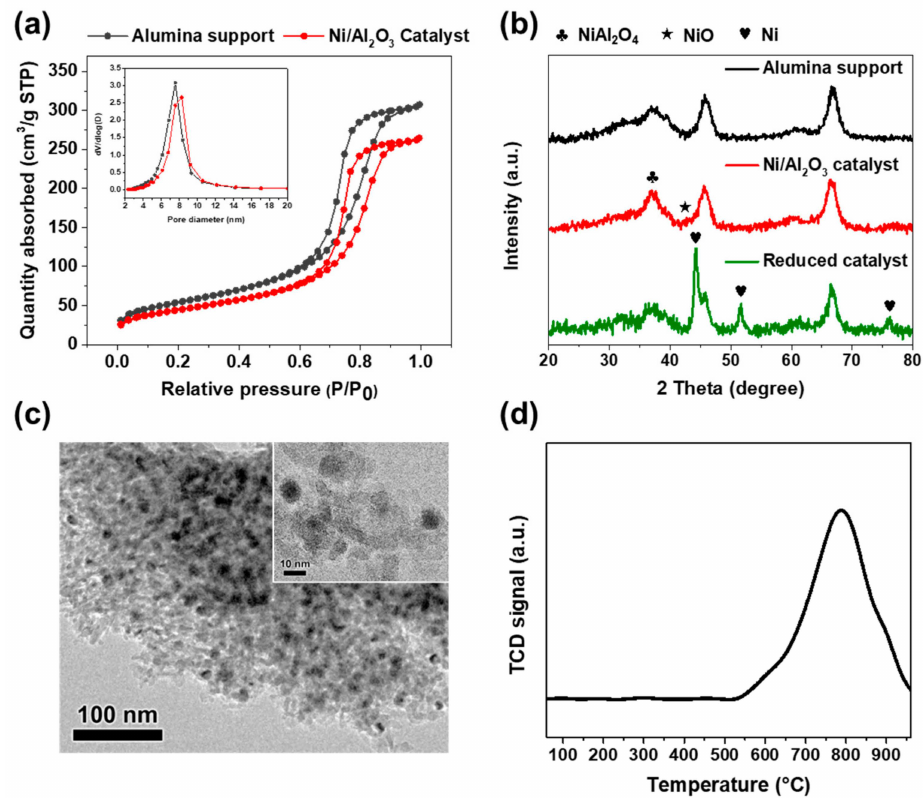
Figure 1. ( a ) N 2 adsorption–desorption isotherms and pore diameter distribution of alumina support and Ni/Al 2 O 3 catalyst, ( b ) X-ray diffraction (XRD) patterns of alumina support, Ni/Al 2 O 3 catalyst, and reduced Ni/Al 2 O 3 catalyst, ( c ) Transmission Electron Microscopy (TEM) images of reduced Ni/Al 2 O 3 catalyst, and ( d ) H 2 temperature-programmed reduction (H 2 -TPR) profile of Ni/Al 2 O 3 catalyst from 60 to 960 ◦ C with a linear rate of 5 ◦